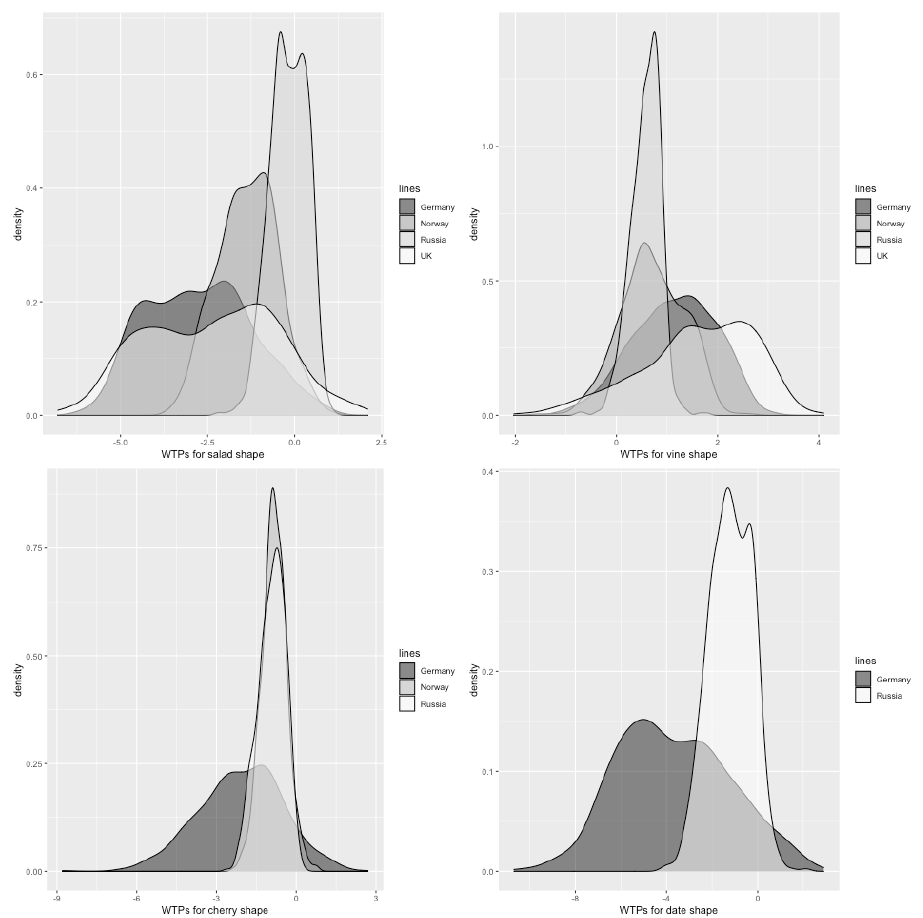
Figure 2. Kernel density plots for conditional WTPs for tomato